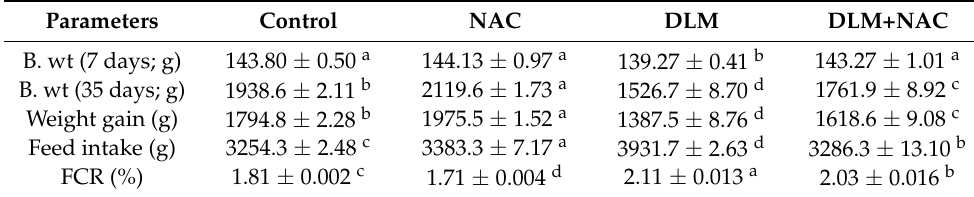
Table 3. Effect of DLM and/or NAC on growth performance.